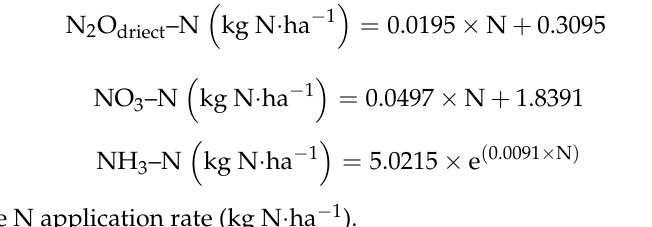
Table 1. Application rate of agricultural inputs in the forage sorghum production system. Agricultural